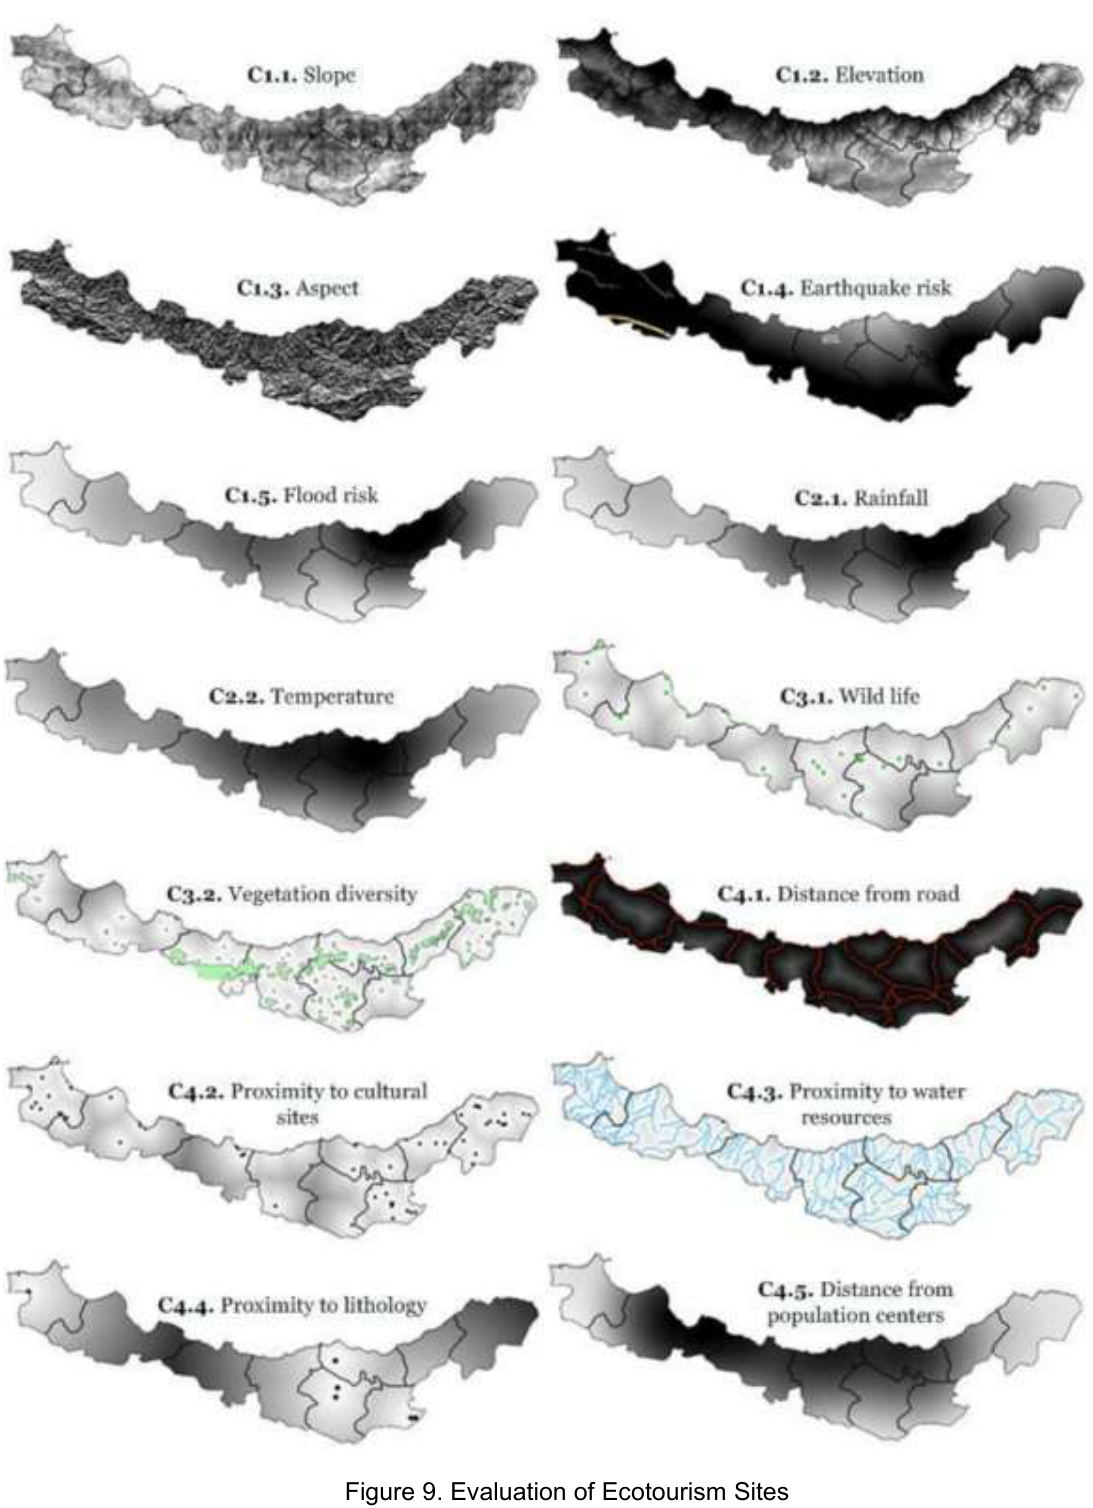
Figure 9. Evaluation of Ecotourism